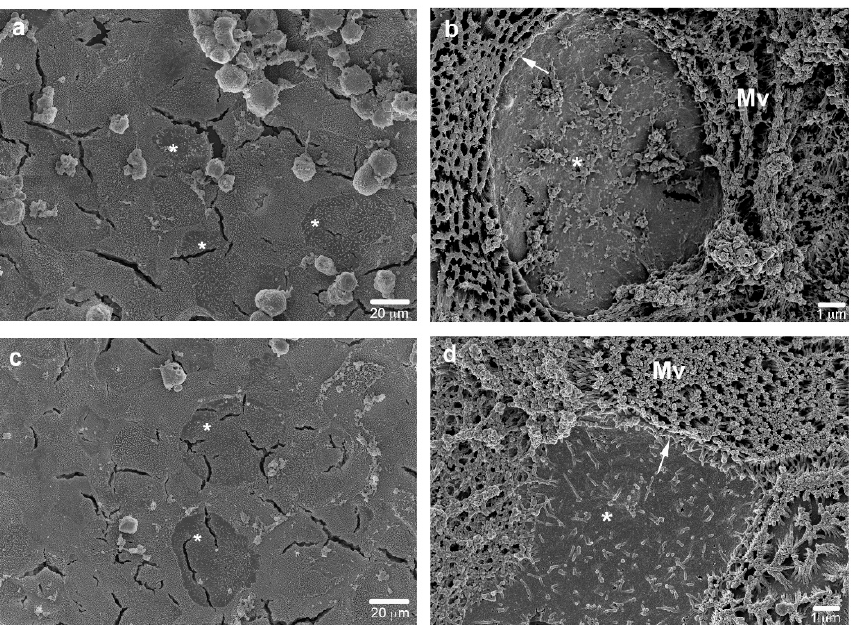
Figure 4. Caco-2 ( a , b ) or Caco-2/HT29-MTX cultures ( c , d ) grown in Raji B conditioned medium, at 21st day of culture. SEM micrographs show the ability of the only conditioned medium to induce the loss of surface microvilli both in Caco-2 ( b ) or Caco-2/HT29-MTX cultures ( d ). Bars a and c 20 µ m; b and d 1 µ m.